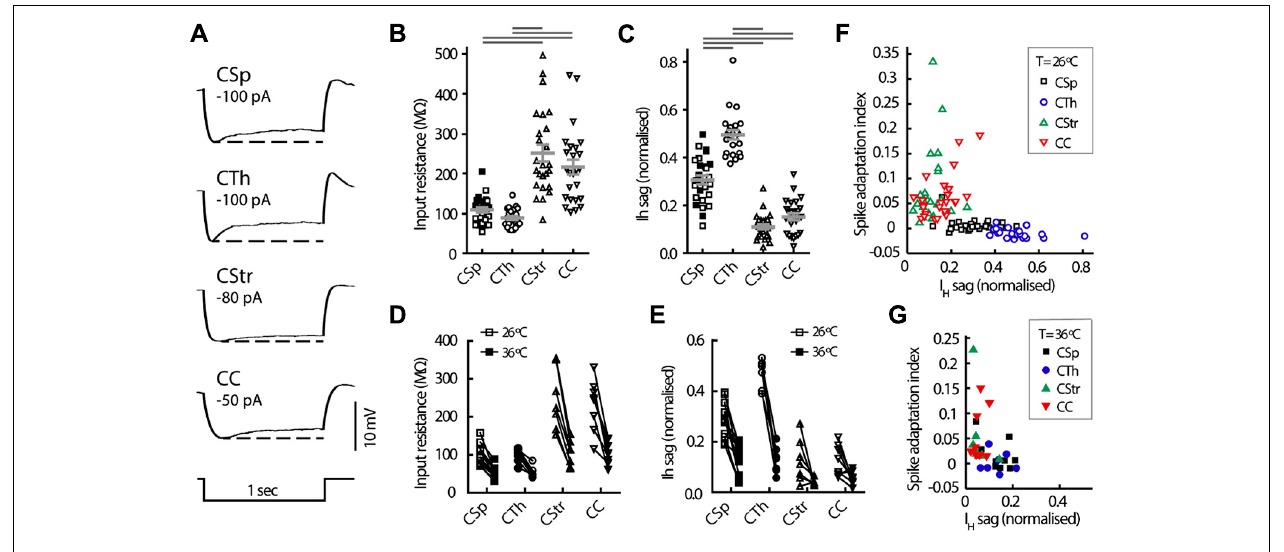
FIGURE 5 | Intrinsic electrophysiological properties of M1 layer 5 neurons grouped by projection target. (A) Representative voltage responses to hyperpolarising current injection in the four cell groups at 26 ◦ C . Note the differences in size and kinetics of the I H mediated depolarisation (or sag) seen after the peak hyperpolarisation, dashed line. Distribution of the cell input resistance (B) and sag potential (C) in the different cell groups at 26 ◦ C (means ± SEM indicated in gray, filled and open squares respectively for lumbar and cervical CSp neurons).